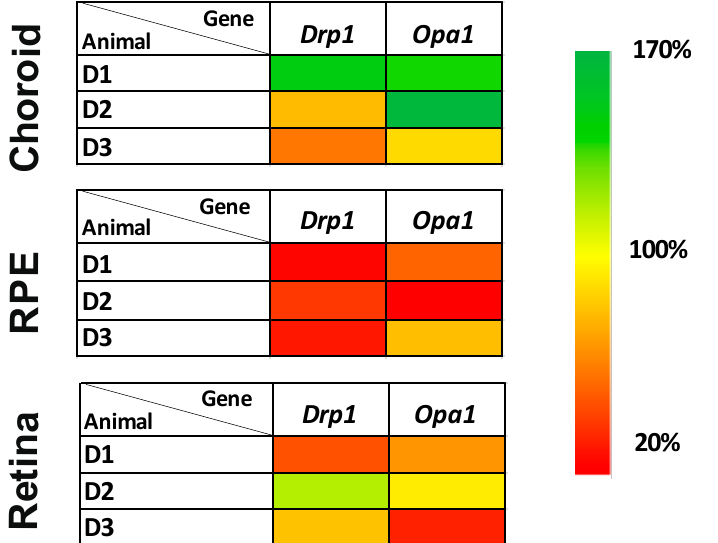
Figure 7. Expression of selected mRNA in different layers of minipig eyes after high intraocular pressure-induced retinal ischemia. The heatmaps show different gene expressions in each layer of the eye. Diseased/retinal ischemic right eyes were compared to control left eyes and normalized to reference gene Rps18 . The changes in selected genes are most profound in the RPE layer. Drp1 (Dnm1L) gene is decreased in RPE ( p < 0.0005), signifying potential DRP1 inhibition or disruption of the balance of mitochondrial dynamics. D1, D2 and D3 are diseased/retinal ischemia right eye of each minipig after intraocular pressure elevation. Scale on the right shows the degree of the expression change. Further comparisons of groups (control eyes versus eyes after intraocular pressure-induced retinal ischemia) are shown in Supplementary Figure S5.